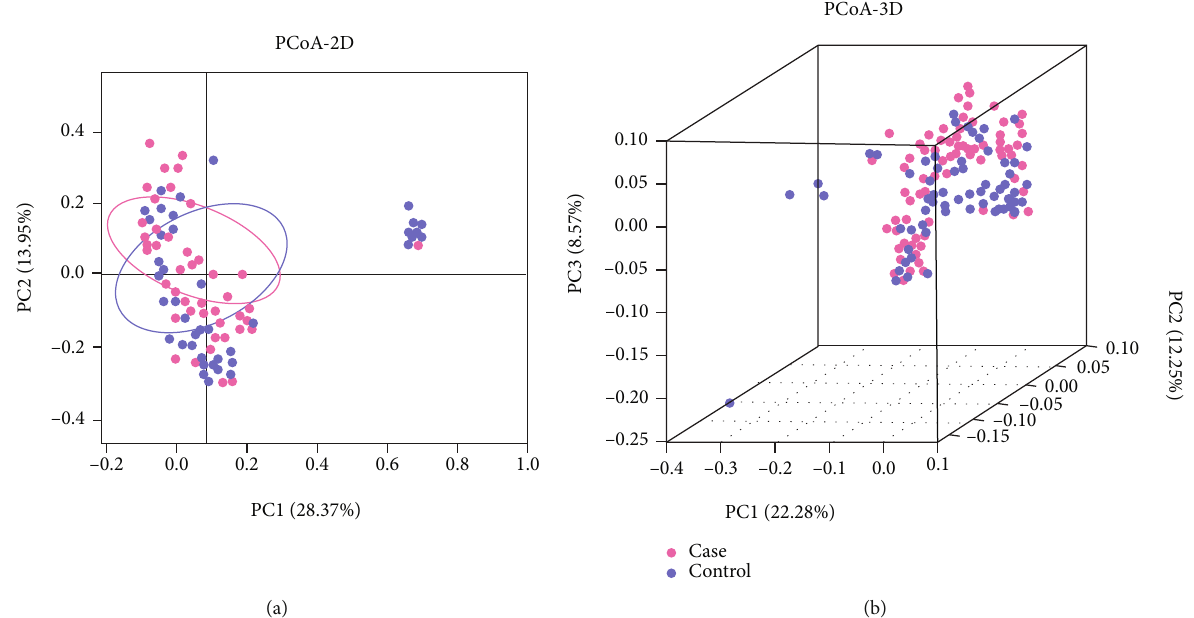
Figure 4: The analysis of PCoA by 2D and 3D models. (a) Two-dimensional map. (b) Three-dimensional map. PCoA map can be de fi ned based on the distance matrix between samples to observe the di ff erences of microbial populations between samples. If the abundance of the gut microbiota of the 2 samples is similar, the distance between the 2 points on the PCoA map will be closer. If the sample has good repeatability, the circle area is small; otherwise, the color area is large. Each dot represented one sample by pink (case group) or blue (control group) in the map. PCoA: principal coordinate